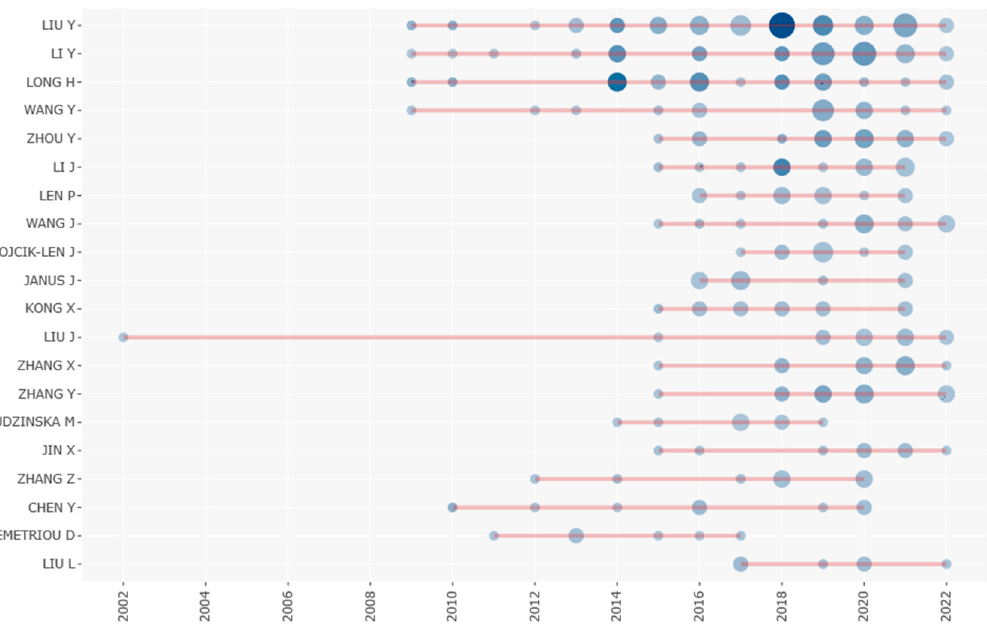
Figure 4. Numbers of publications and citations per year of the top 20 influential authors in the field of land consolidation and rural